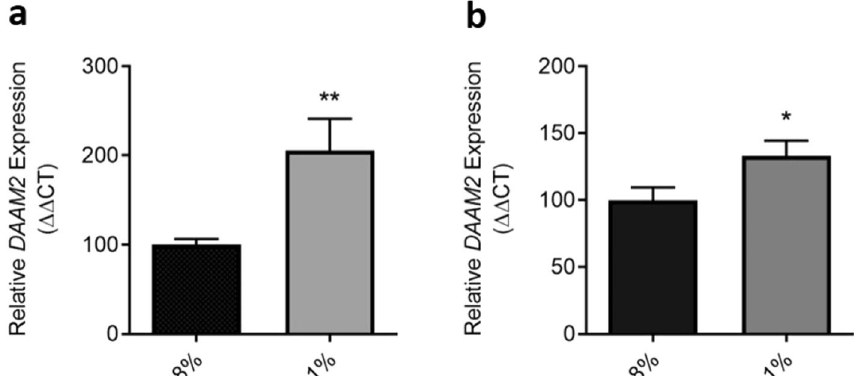
Figure 4. Expression of DAAM2 mRNA in primary cytotrophoblasts and placental explant tissue under normoxic (8% O 2 ) and hypoxic (1% O 2 ) conditions. Cytotrophoblast ( a ) and placental explant ( b ) expression of DAAM2 mRNA is significantly upregulated under hypoxic conditions, compared to normoxic control. Data presented as fold change from control ± SEM. *p < 0.05, **p < 0.01. n = 4–5 experimental replicates (each sample from a different patient), with each experiment performed in